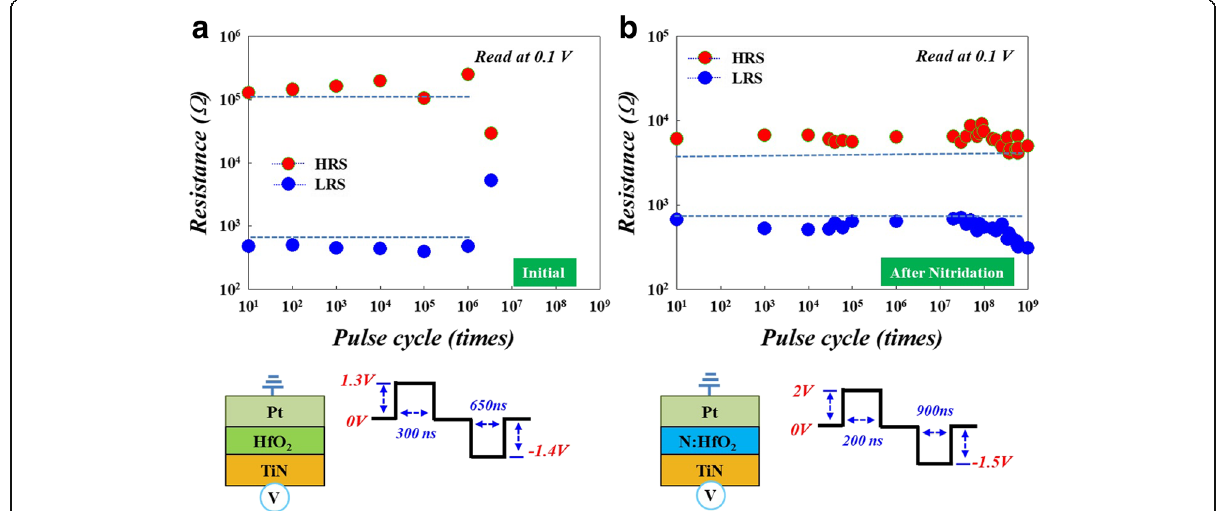
Fig. 2 Comparison of endurance times in HfO 2 -based RRAM: a initial and b after nitridation treatment. The bottom diagrams are the corresponding device structures and endurance pulse conditions